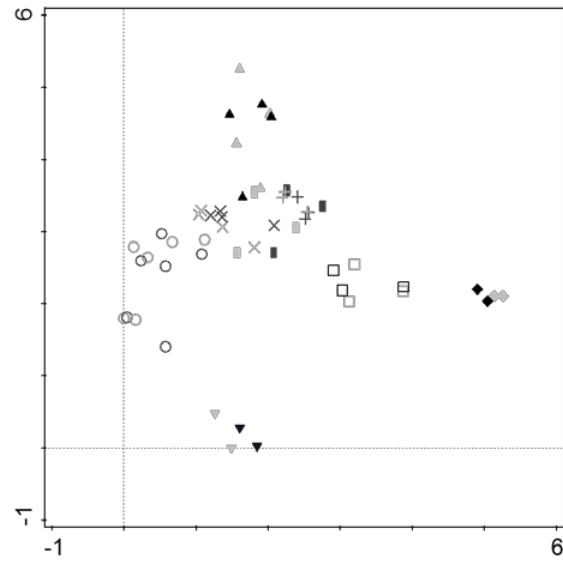
Figure 8. Detrended correspondence analysis of vegetation relevés from the selected sampling plots along the five transects in the Rospuda mire (Figure 2). Grey symbols: relevés recorded in 2006–2008 (presented by Jabłońska et al. 2011); black symbols: relevés recorded in 2016. For this analysis, vegetation layers were not